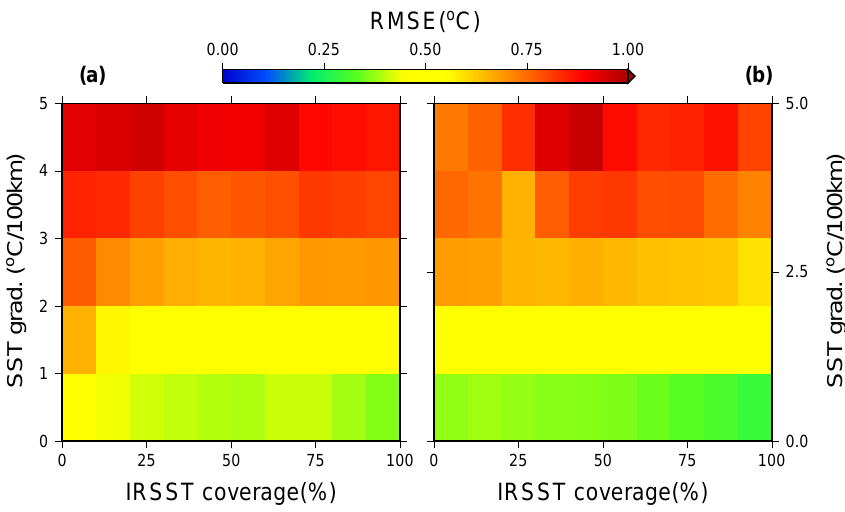
Figure 9. Accuracy (RMSE) of the blended SST product depending on the infrared (IR) SST coverage (horizontal axis) in the three-dimensional range searching data for optimal interpolation (OI) and the SST gradient (vertical axis) derived from the blended SST data. The coastal areas (oceans from coastline ≤ 200 km) were excluded from the calculation. ( a ) Period without AMSR2 10-GHz SST data (until July 2012); and ( b ) period with AMSR2 10-GHz data (after July 2012, except for low-temperature areas ( < 11 ◦ C)). RMSEs were calculated in each 10% × 1 ◦ C/100 km